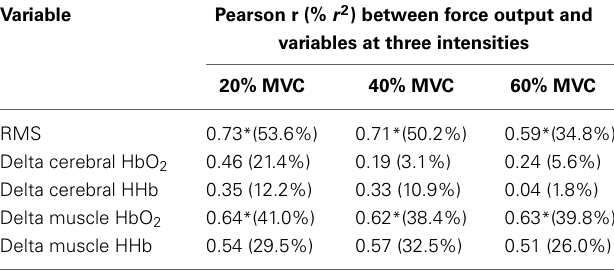
Table 2 | Pearson correlations and common variance (in parentheses) between force output and selected electromyographic, cerebral, and muscle hemodynamic variables during intermittent contractions of the biceps brachii at three intensities ( N = 11, critical ‘ r ’ value = 0.58). Variable Pearson r (% r 2 ) between force output and